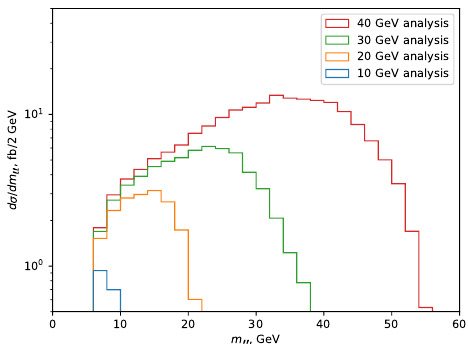
Figure 3 . Dilepton mass distribution for the ‘‘(cid:13) background. All cuts in the text, except for the m ‘‘ resonance requirement, have been imposed, for various target Z 0